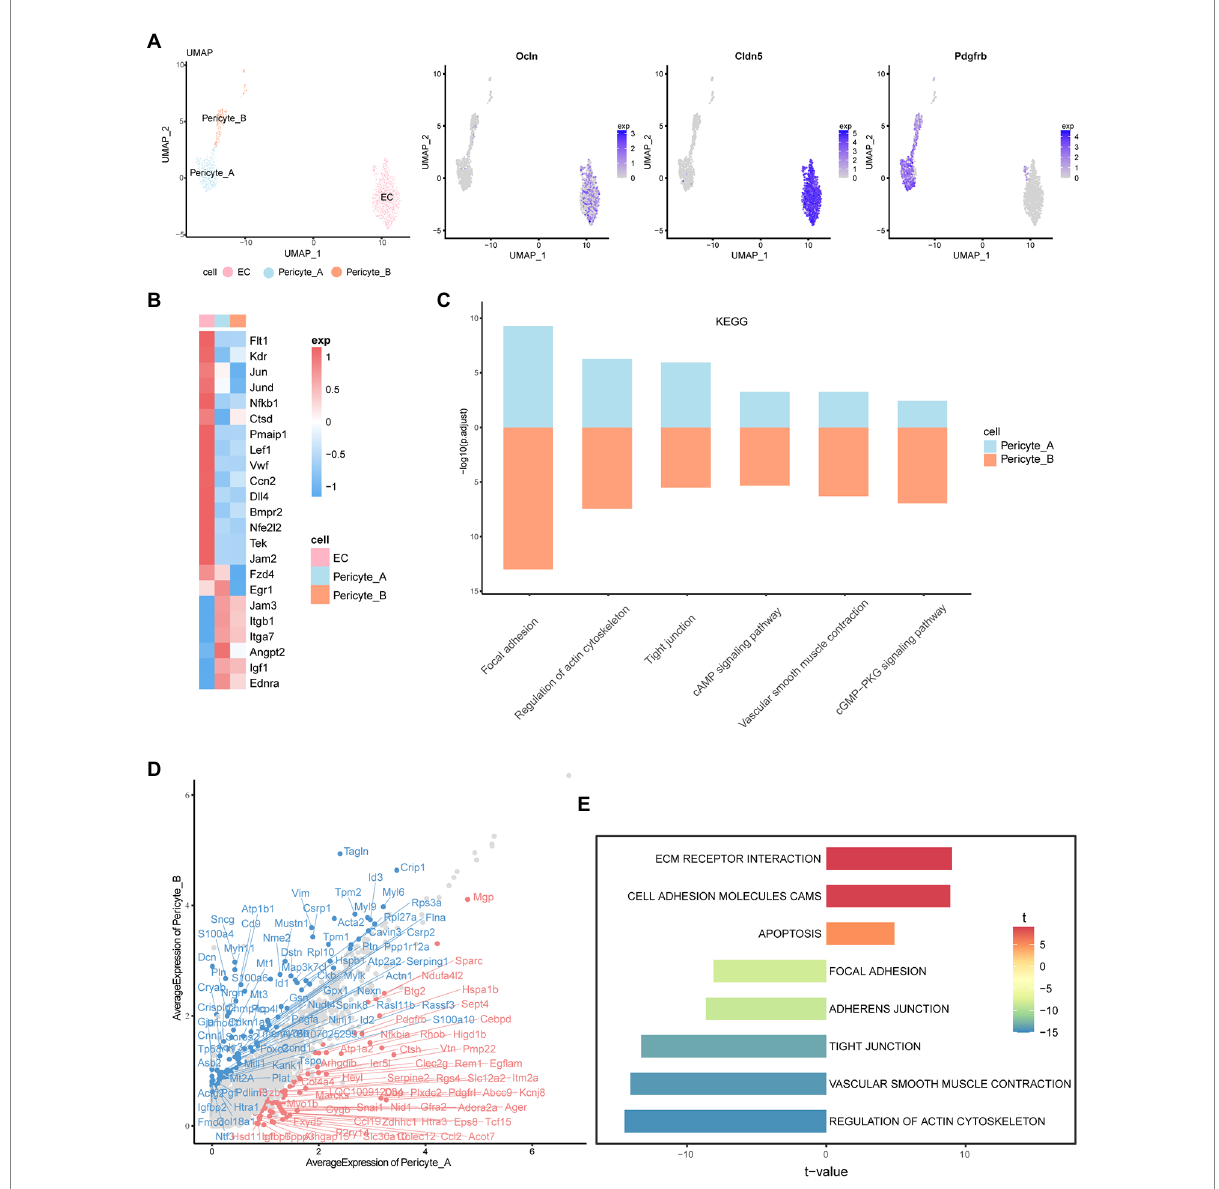
FIGURE 3 Characteristics and interrelationship of endothelial cells and pericytes. (A) UMAP diagram of EC, Pericyte_A, and Pericyte_B. The feature plot shows the expression of marker genes in each of the three cells. (B) The heatmap shows the expression of important cytokines in the three groups of cells. High expression is in red, and low expression is in blue. (C) The histogram shows the KEGG enrichment results of Pericyte_A and Pericyte_B, and the length represents -log10 (p.adjust). (D) The scatter plot shows the difference in gene expression between the two groups of cells. The red one is the upregulated gene of Pericyte_A relative to Pericyte_B. Genes with abs (avg_logFC) ≥ log2 (1.55) and p_val_adj ≤ 0.01 are labeled. (E) The two-way histogram shows the GSVA enrichment results of Pericyte_A compared with Pericyte_B, and both length and color represent the t value. T value is the statistical value of the t test, which is used to infer the size of p